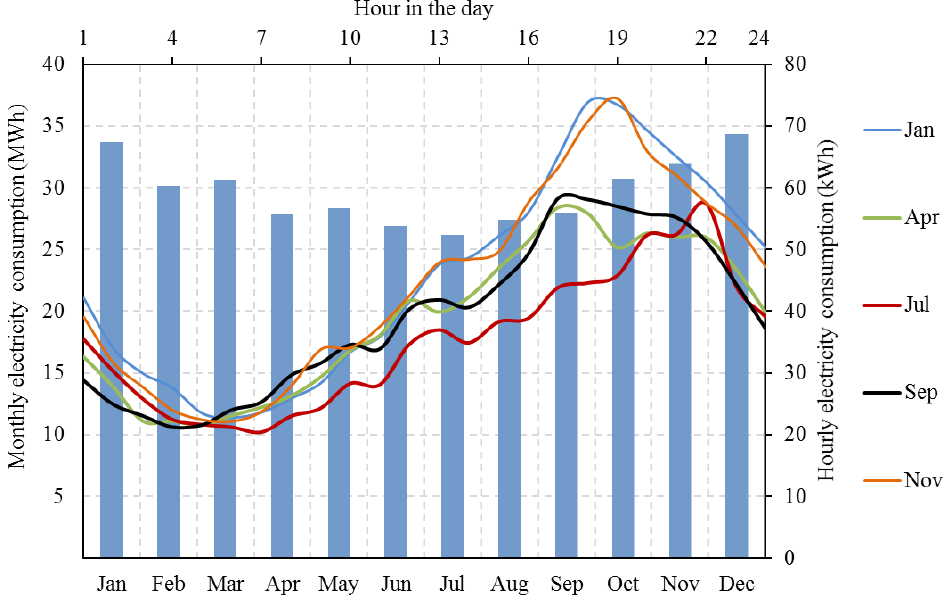
Figure 1. Hourly and monthly average electricity demand of the selected building.